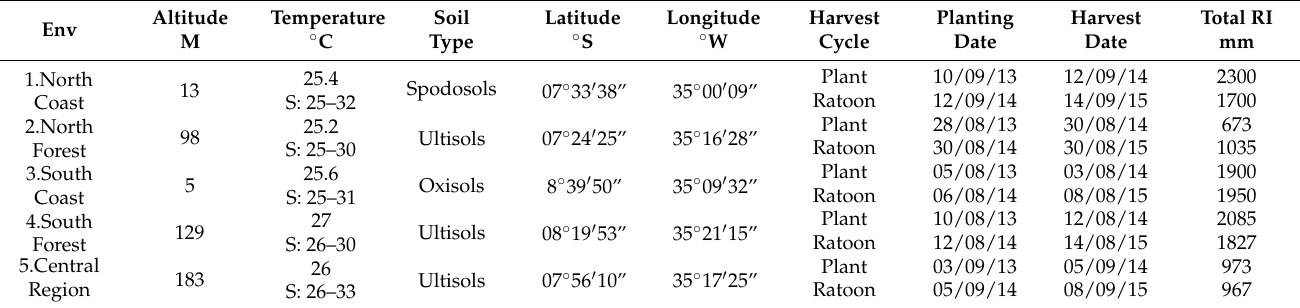
Table 1. Environment’s description, geographic coordinates of test locations and general data on experimental conditions. Altitude Temperature Soil Latitude Longitude Harvest Planting Harvest Env ◦ C ◦ S ◦ W M Type Cycle Date